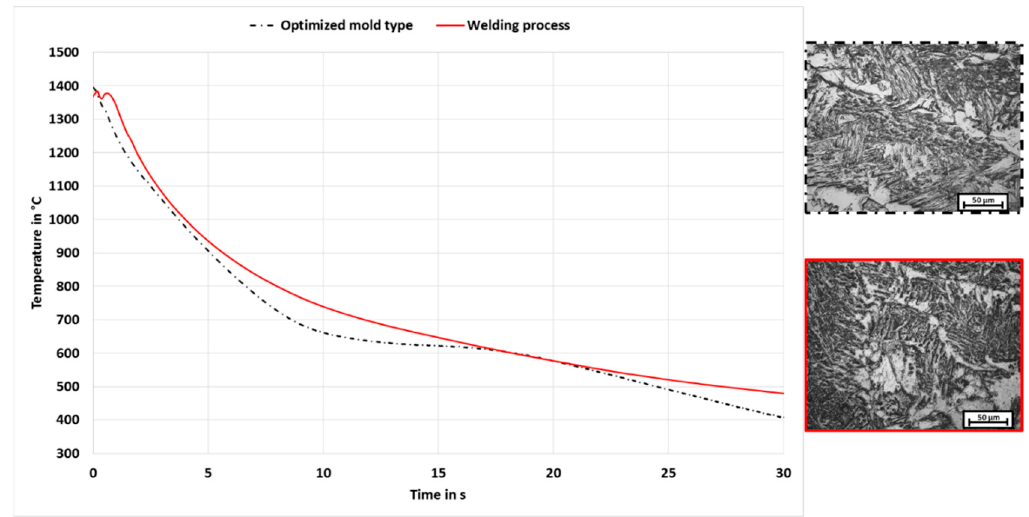
Figure 14. Comparison of cooling behavior and microstructure of the welding and optimized casting process.